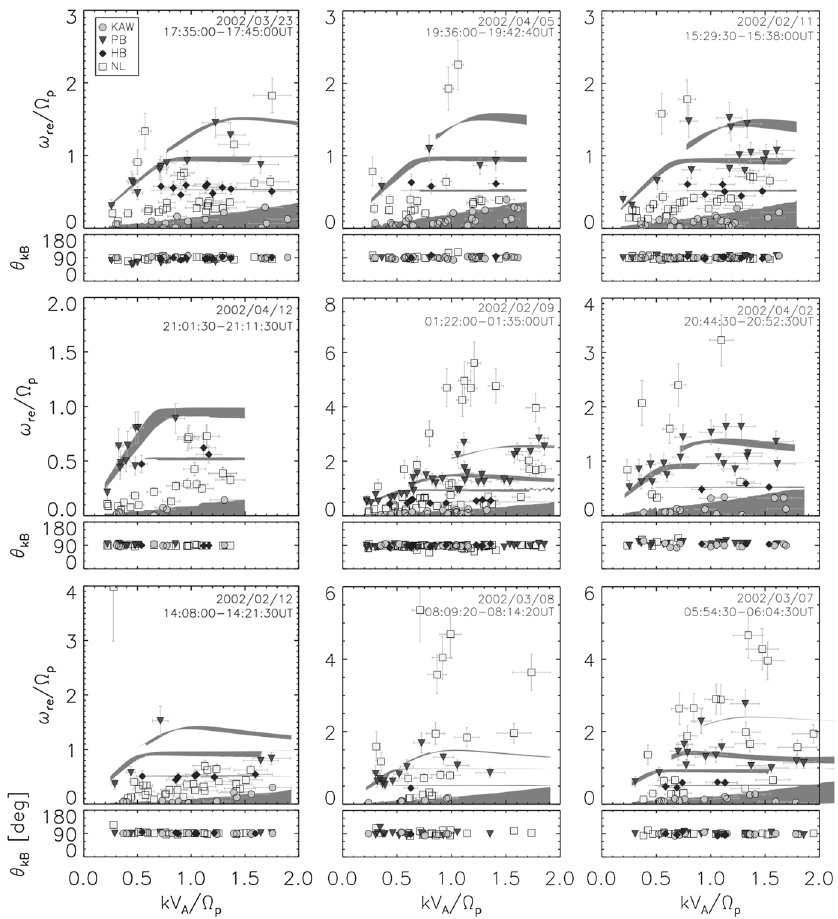
Fig.10 Dispersionrelationdiagramsandpropagationanglesobservedinthesolarwind.Thedetectedwave components(asetofthefrequenciesandthewavenumbers)areassociatedwithdifferentwavemodes:kinetic Alfvén mode (in circles), ion Bernstein mode for protons (in triangles) and for helium alpha particles (in diamonts),andnon-linearorsidebandmode(insquares). ImagereproducedwithpermissionfromPerschke et al. (2014), copyright by